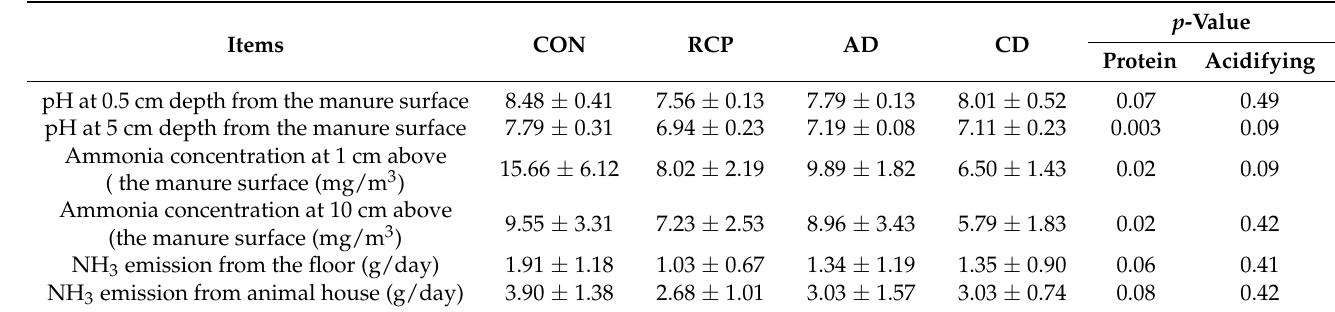
Table 7. pH and ammonia emissions from growing-finishing pig house as affected by experimental diets (mean ± standard deviation, n =